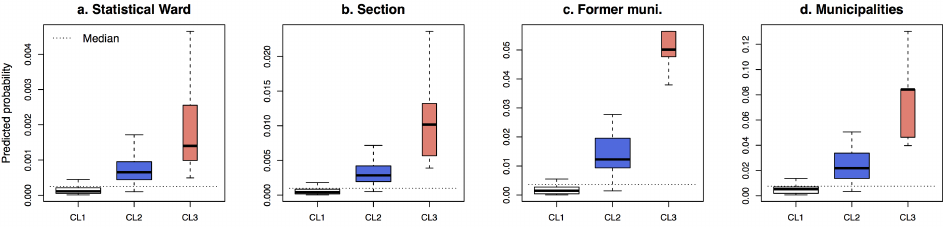
Figure A.2: Variations of predicted probability per cluster for the Monocentric case study (box-plots width is function of the number of observations)